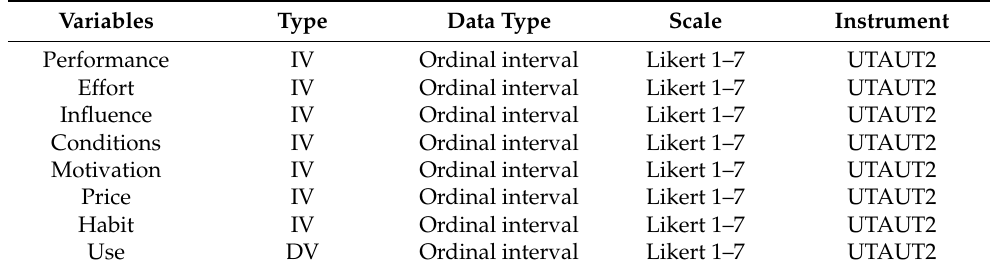
Table 3. Instrument data collection